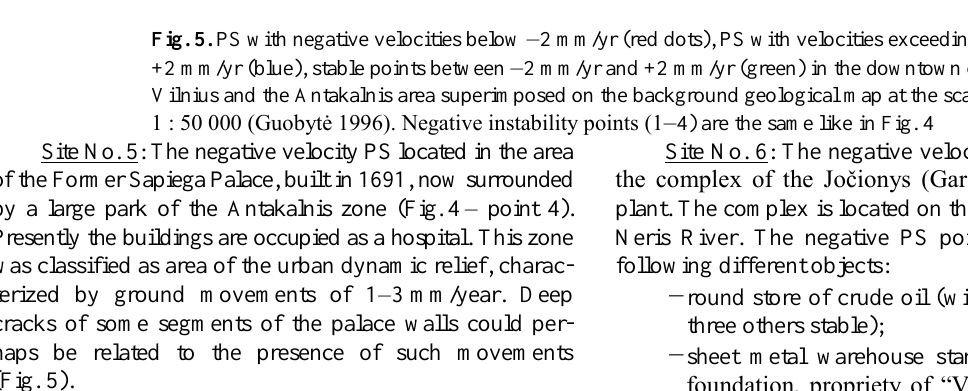
Fig. 5. PS with negative velocities below – 2 mm/yr (red dots), PS with velocities exceeding +2 mm/yr (blue), stable points between – 2 mm/yr and +2 mm/yr (green) in the downtown of Vilnius and the Antakalnis area superimposed on the background geological map at the scale 1 : 50 000 (Guobytė 1996). Negative instability points (1 – 4) are the same like in Fig. 4